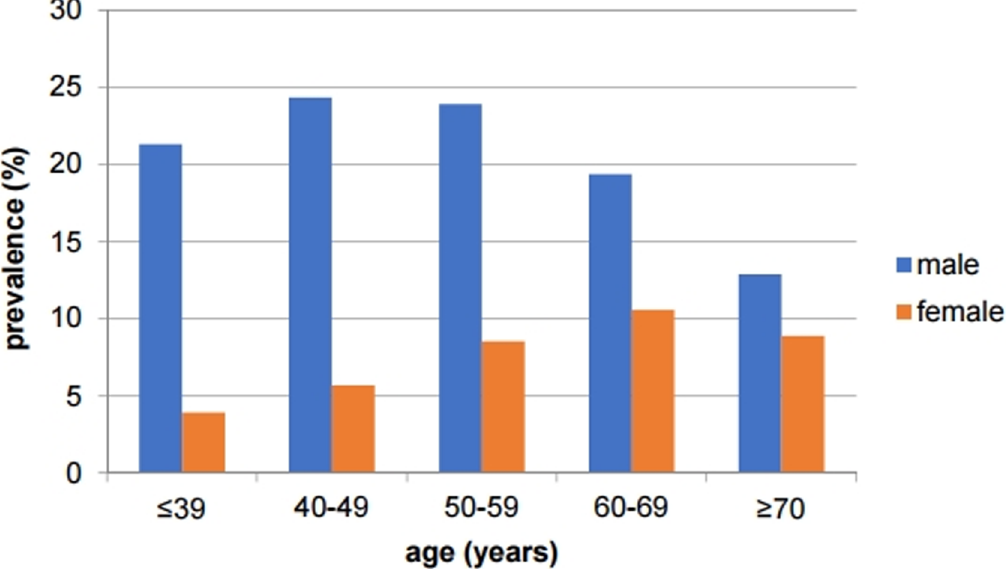
Fig 1. Age and gender distributions for the prevalence of erosive esophagitis. At all ages, male subjects were diagnosed with erosive esophagitis more frequently than female subjects.